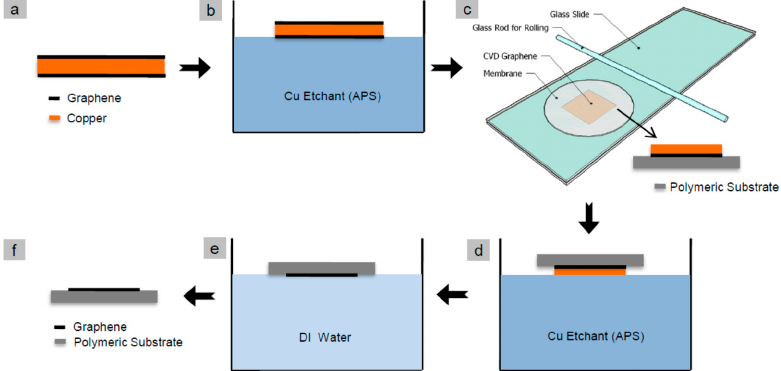
Figure 1. Monolayer graphene transfer process to polymeric substrates: ( a ) commercial monolayer chemical vapor deposition (CVD) graphene with graphene on both sides of the Cu foil; ( b ) removal of graphene from one side of the foil by floating over ammonium persulfate (APS) copper etchant for 10 min; ( c ) Cu/graphene attachment to the polymeric substrate by sandwiching between two glass slides and gentle press rolling with the glass rod; ( d ) Copper removal by wet etching process using APS etchant for 2 h; ( e ) Graphene/substrate washing process by two de-ionized baths for 10 min